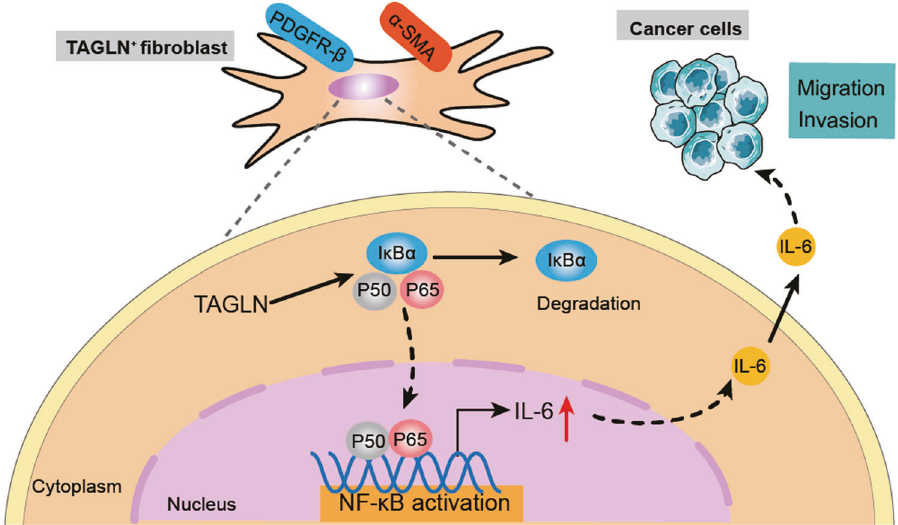
Fig. 8 TAGLN promotes lung cancer progression via activation of cancer-associated fi broblasts with enhanced IL-6 release. TAGLN promoted the pro-tumor phenotype of fi broblasts and increased their secretion of pro-in fl ammatory cytokines, such as IL-6, via the activation of the NF- κ B signaling pathway which in turn regulates lung cancer cells